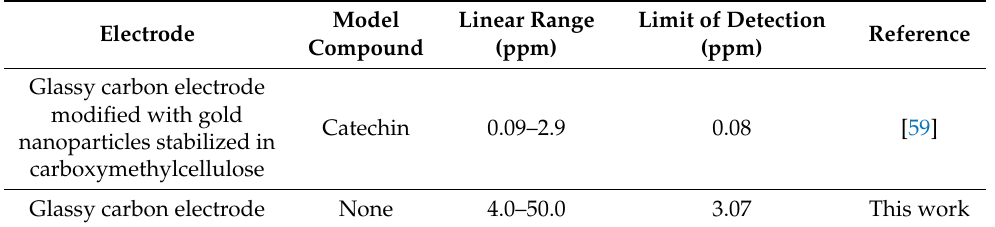
Table 1. A comparison of this protocol with other protocols using catechin as a model